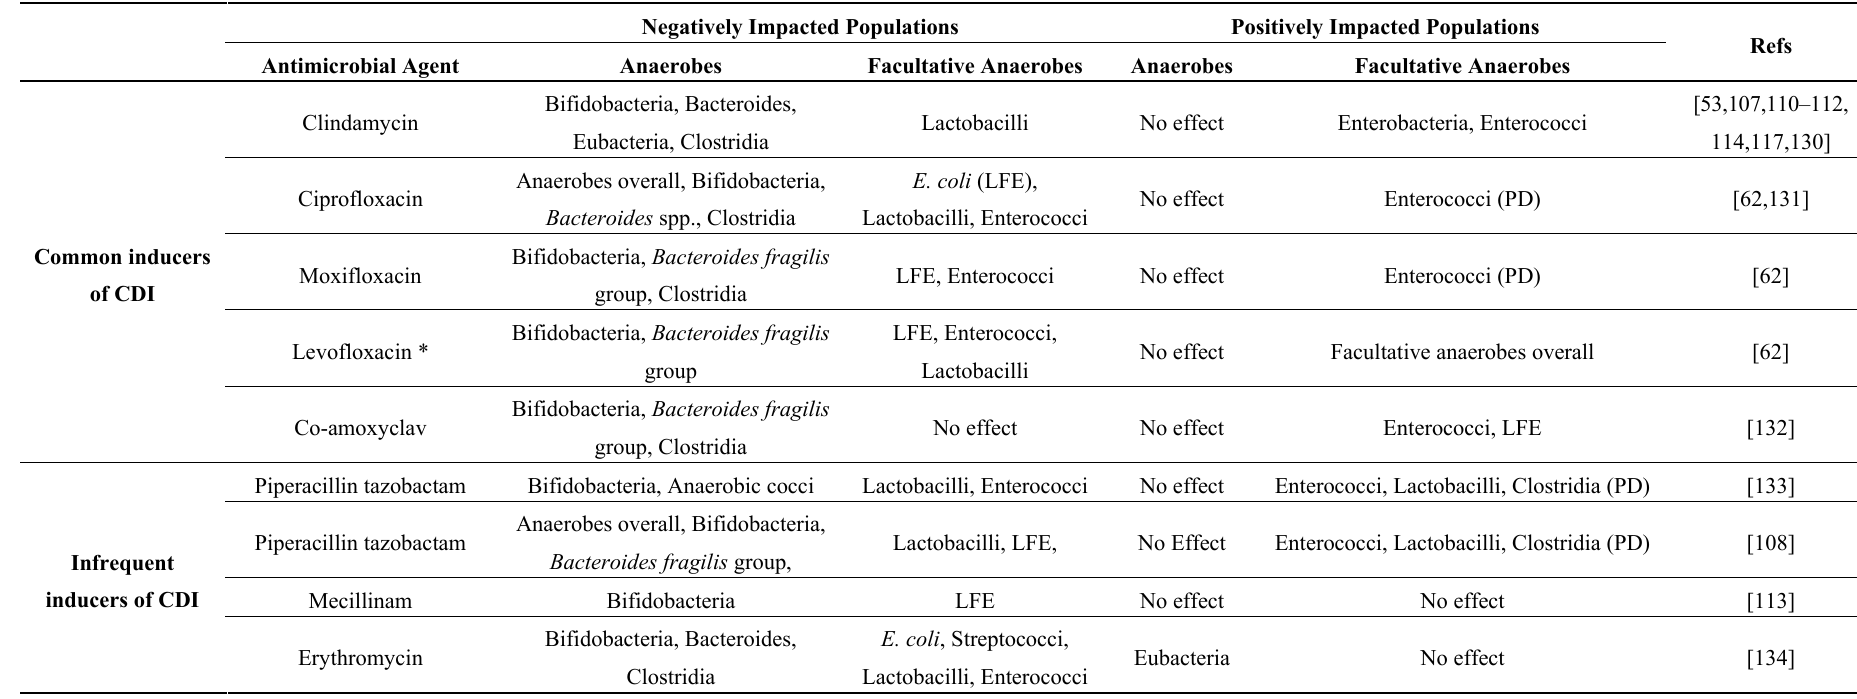
Table 2. Changes in selected indigenous gut microflora populations following exposure to antimicrobial agents in vitro and in